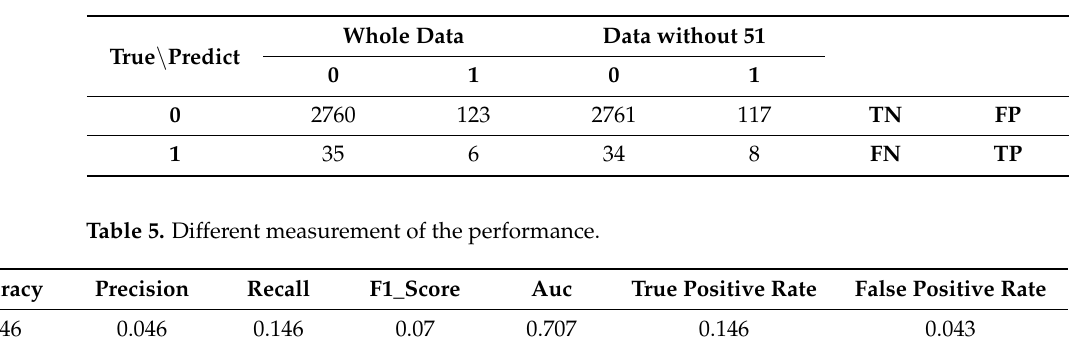
Table 4. The performance comparison of the autoencoder results which are trained by different training data.